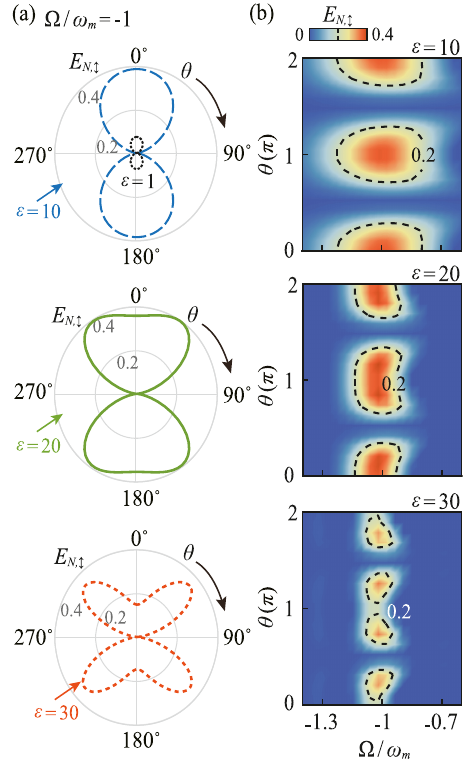
Figure 3: Polarization-controlled optomechanical entanglement within the cavity output mode. (a) The logarithmic negativity of the TE mode, E the polarization angle 𝜃 in polar coordinates for different values of the inverse bandwidth 𝜀 , with the central frequency Ω∕ 𝜔 versus the central frequency 𝛺 and the polarization angle 𝜃 for E N , ↕ different values of 𝜀 . There is an optimal value of 𝜃 for achieving the maximum COM entanglement within the cavity output